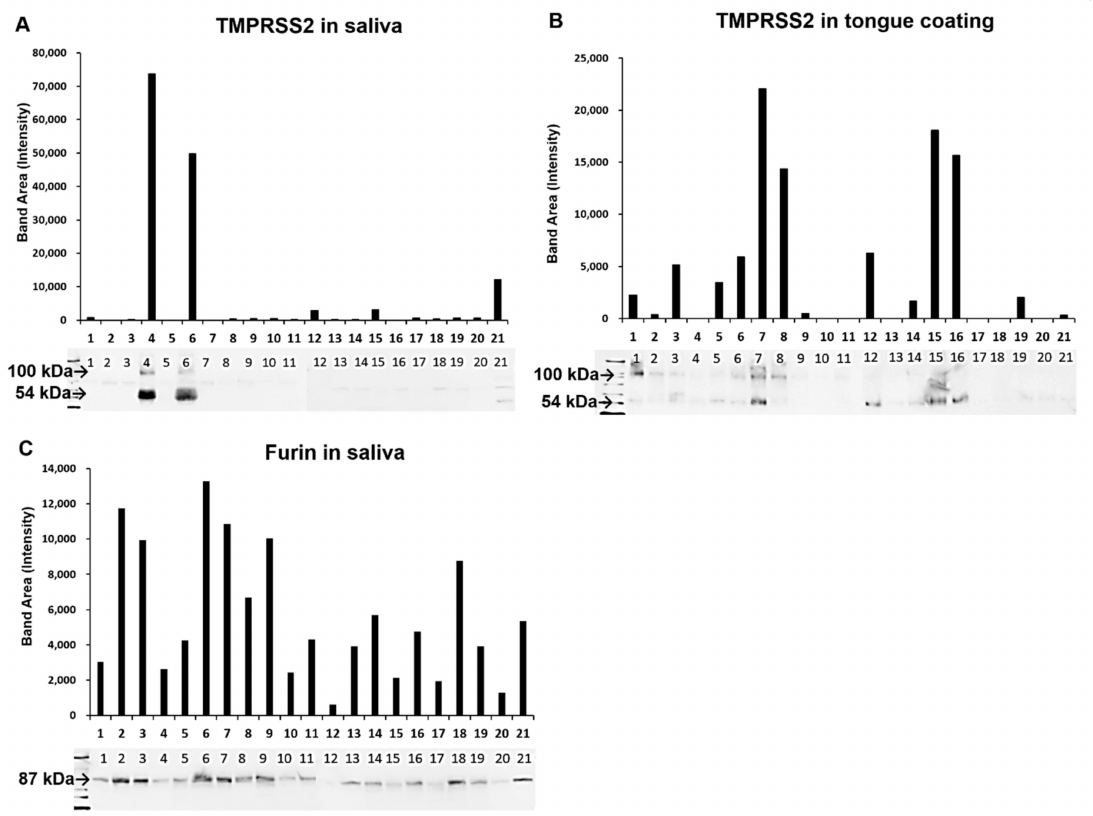
Figure 5. Band signals showing the protein expression levels of TMPRSS2 ( A , B ) and furin ( C ) via Western blot analysis, and a graph showing the intensity of the band area determined using Image J. TMPRSS2, transmembrane protease serine